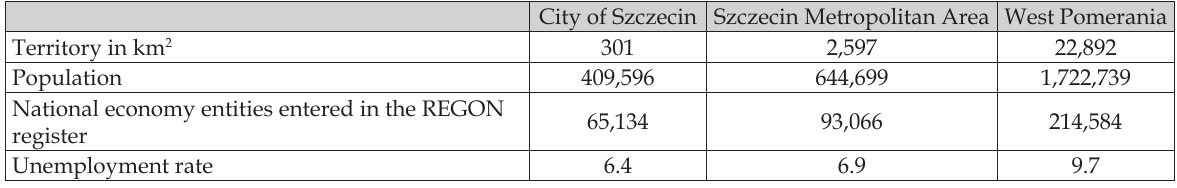
Table 3. Key statistical figures for the city of Szczecin, the Szczecin Metropolitan Area and West Pomeranian voivodeship in